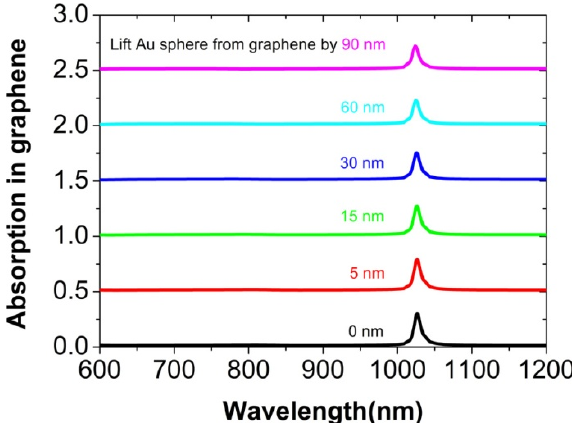
Figure 7. The calculated absorption spectra of the graphene monolayer at normal incidence, when the Au nanosphere is lifted from the graphene by different distances. For clarity, the above absorption spectrum is vertically offset by 0.5 from the one below.